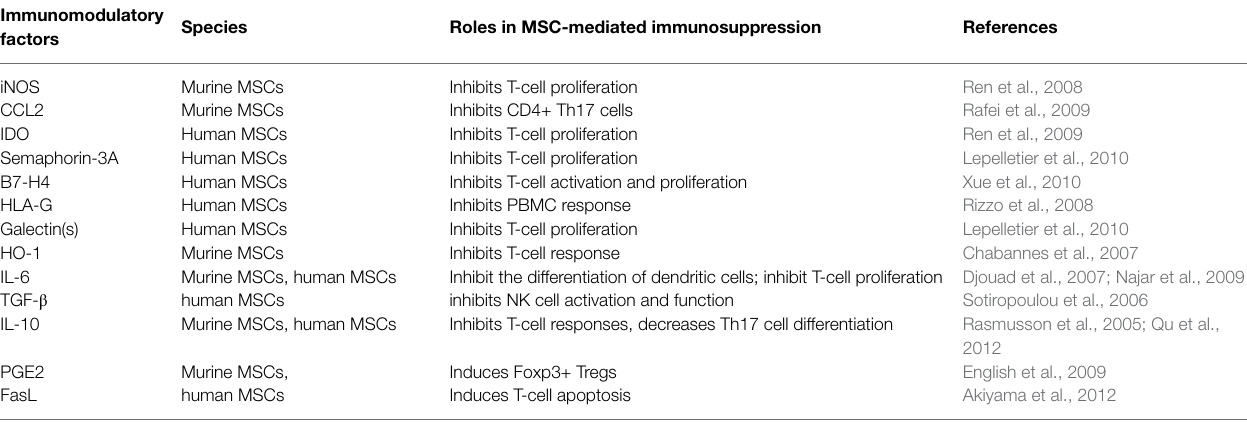
TABLE 1 | Immunological modulation of